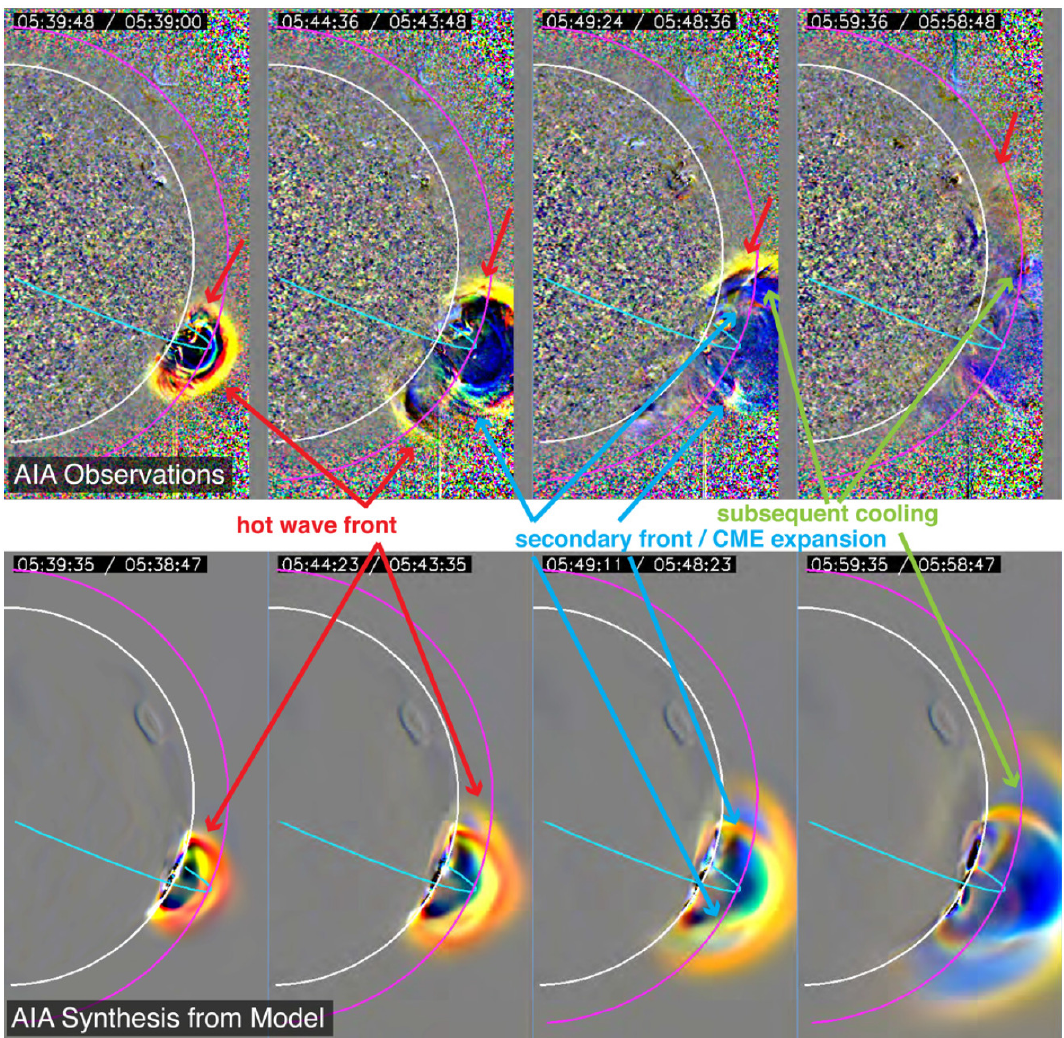
Figure 47: Top : tri-color running ratio images of the 2010 Jun 13 coronal wave observed with AIA at 171 ( blue ), 193 ( green ), and 211 ˚A ( red ). A hot dome-like wavefront is followed by a slower secondary front. Bottom : Synthesized images for the same event obtained from a 3D thermodynamic MHD simulation. Both outer and inner front are reproduced. Image reproduced with permission from Downs et al. (2012), copyright by